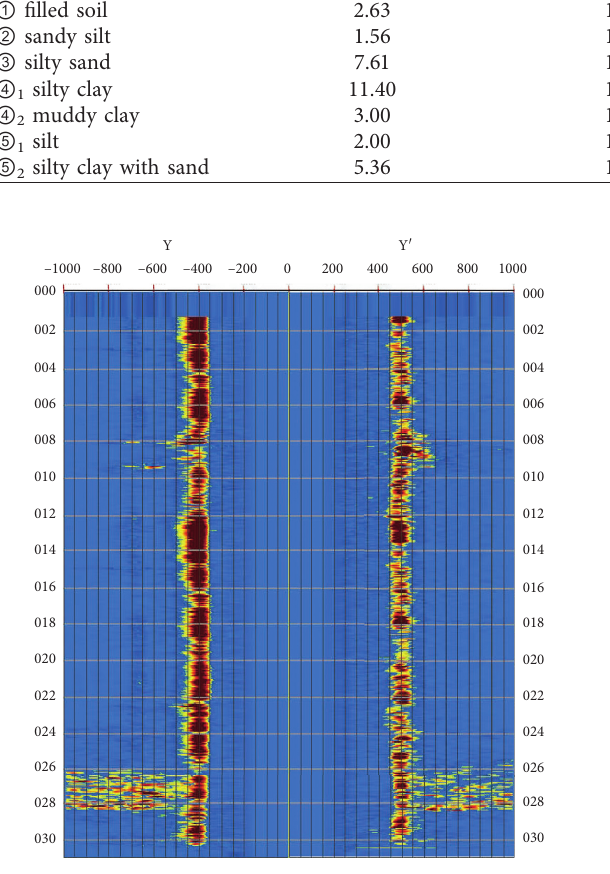
Figure 12: Ultrasonic detection